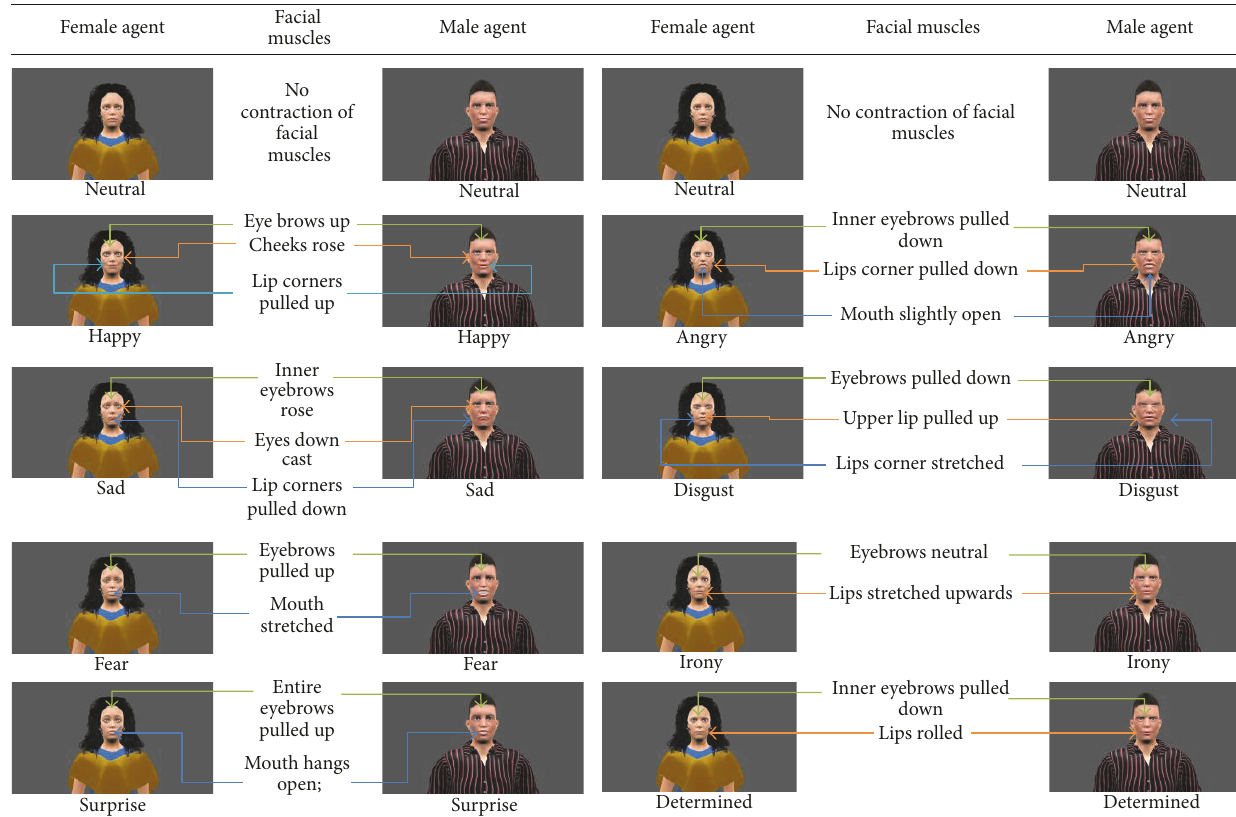
Figure 2: A fragment of generated facial expressions.